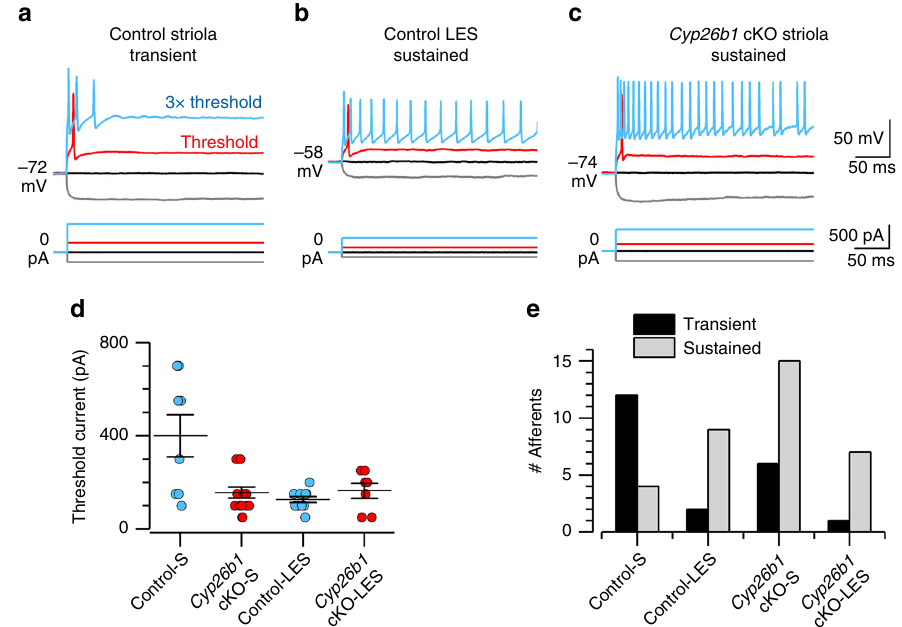
Fig. 5 Neural activity in the striola of Cyp26b1 cKO mice is extrastriolar-like. a – d Cyp26b 1 cKO striolar afferents, like control extrastriolar afferents, were more excitable than control striolar afferents, as shown by their tendency to fi re more spikes and by reduced current thresholds for spiking. a – c Whole-cell current clamp records from patched calyces of a control striolar (Control-S) afferent ( a ), control lateral extrastriolar (Control-LES) afferent ( b ), and a Cyp26b1 cKO striolar ( Cyp26b1 cKO-S) afferent ( c ). Five hundred-millisecond current steps were delivered in 50-pA increments from – 200 pA to >1 nA relative to zero holding current; a subset is shown including the response at threshold current (red). Three times (3×) threshold current- (blue) evoked transient spiking in the control striolar afferent, but sustained spiking in the control-LES afferent and Cyp26b1 cKO-S afferent. d Mean threshold current to activate spikes was signi fi cantly higher in Control-S calyces than in all other categories — that is, the Cyp26b1 cKO-S calyces resembled Cyp26b1 cKO lateral extrastriolar ( Cyp26b1 cKO-LES) calyces and Control-LES calyces. Two-way ANOVA showed main effects of genotype (control vs. Cyp26b1 cKO, F (1,41) = 6.1, P = 0.02), zone (striola vs. LES, F (1,41) = 10.0, P = 0.003) and their interaction ( F (1,41) = 11.2, P = 0.002). Control-S afferents (400 ± 90 pA, n = 8) differed signi fi cantly from each other category, including control-LES afferents (127.3 ± 12 pA, n = 11; P = 0.0003, effect size 1.9) and Cyp26b1 cKO-S afferents (156.3 ± 23 pA, n = 16; P = 0.0005, effect size 1.6). Cyp26b1 cKO-S afferents did not differ from control-LES afferents ( P = 0.94) or Cyp26b1 cKO- LES afferents (164 ± 32 pA, n = 7, P > 0.99). e Transient fi ring was more common than sustained fi ring in Control-S afferents; sustained fi ring was